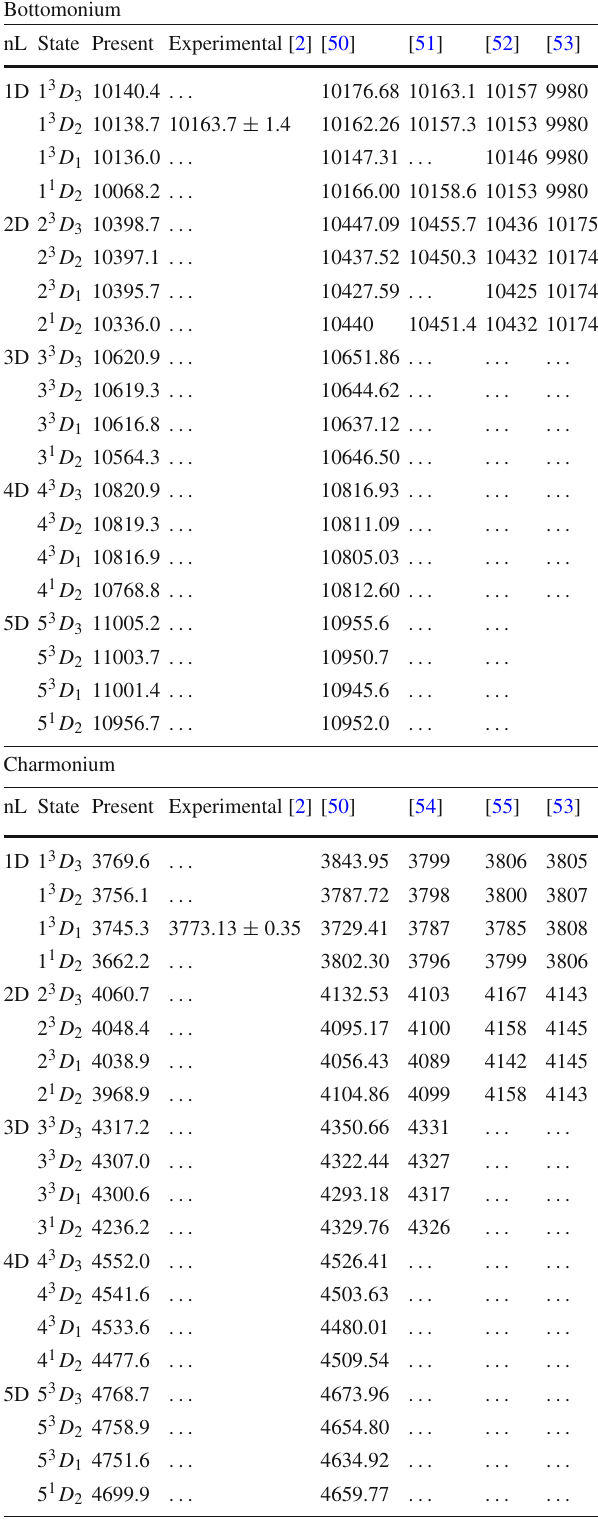
Table 5 D-wave mass spectrum for b ¯ b and c ¯ c bound states (in MeV) Bottomonium